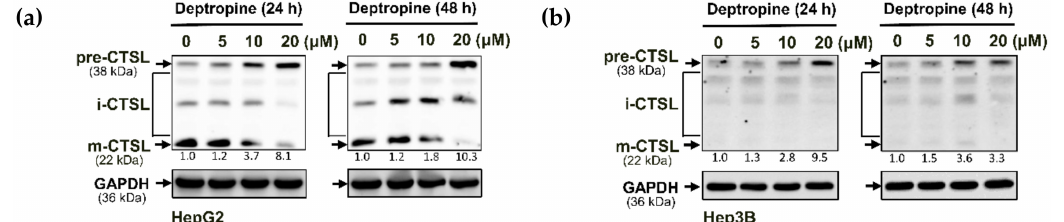
Figure 5. E ff ects of deptropine on the lysosomal activity of human hepatoma cells. ( a ) Hep3B and ( b ) HepG2 cells were treated with di ff erent concentrations of deptropine for 24 and 48 h. Total cell lysates were collected, and the precursor form (pre-), intermediate (i-), and mature (m-) form of the cathepsin L (CTSL) protein were detected by Western blotting. The relative intensity of pre-CTSL was normalized to the GAPDH loading control and indicated below the